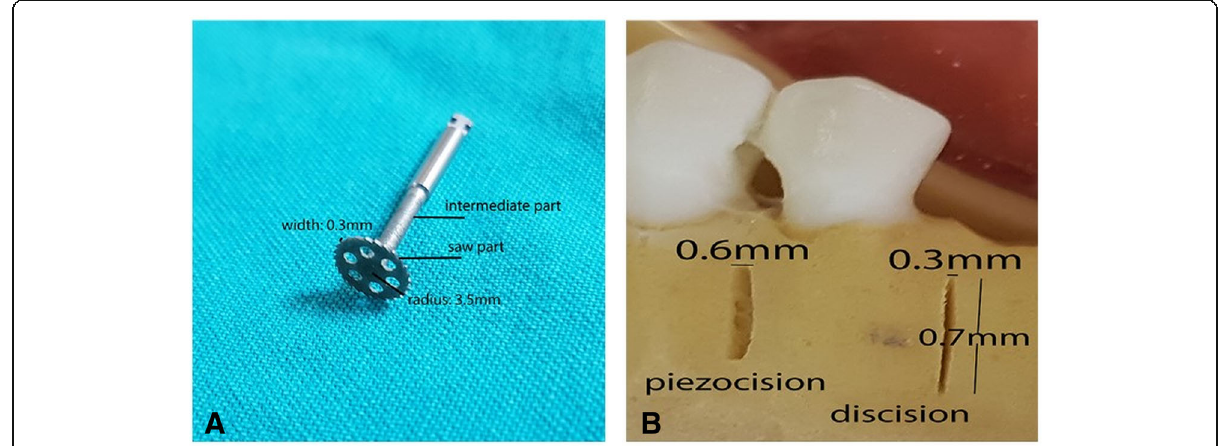
Fig. 2 a Disc saw. b Comparison of piezocision and discision in a dental study model